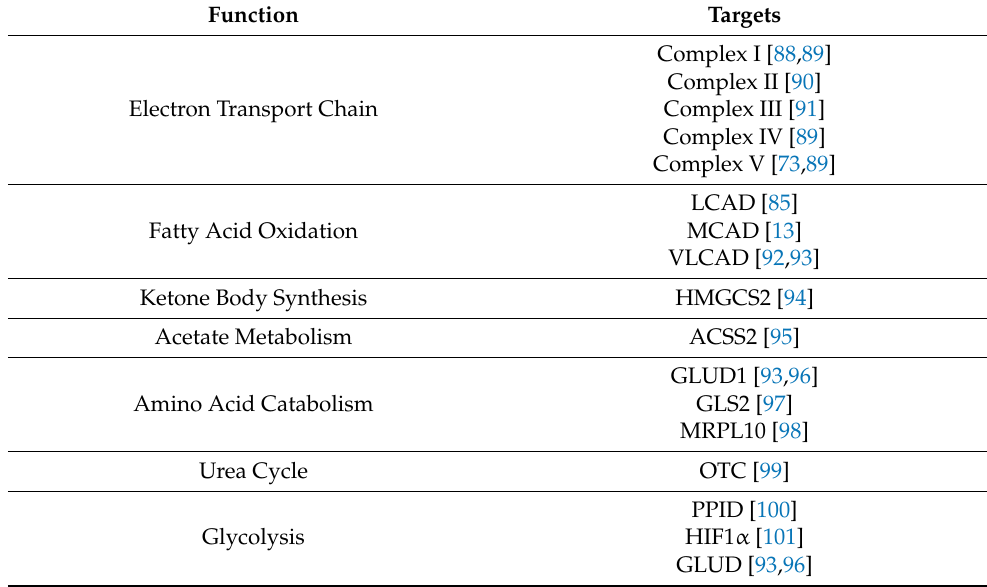
Table 3. Metabolic targets of